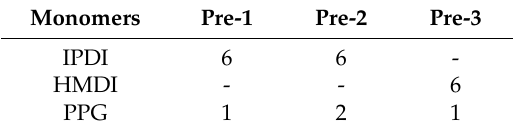
Table 1. The molar ratios of the monomers employed in the synthesis of the quasi-prepolymer. Monomers